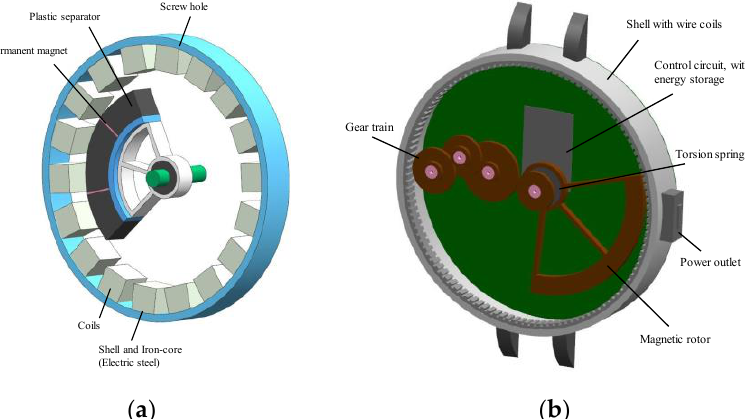
Figure 4. ( a ) Eccentric rotor energy harvester [53]. ( b ) Novel magnetic rotor energy harvester [54].